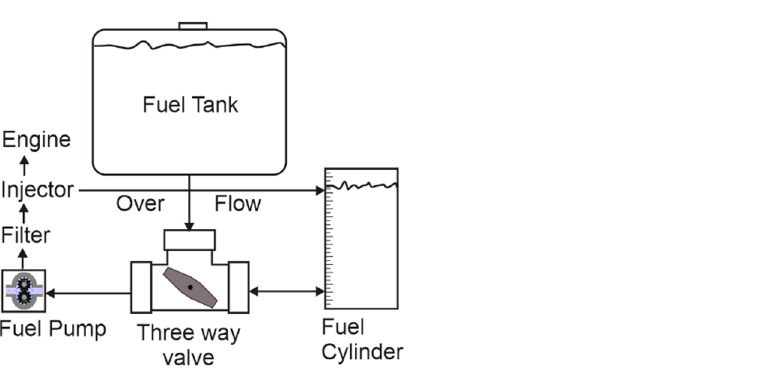
Figure 3. Schematic diagram of the tractor fuel consumption measuring system in the field experimental ploughing operations.